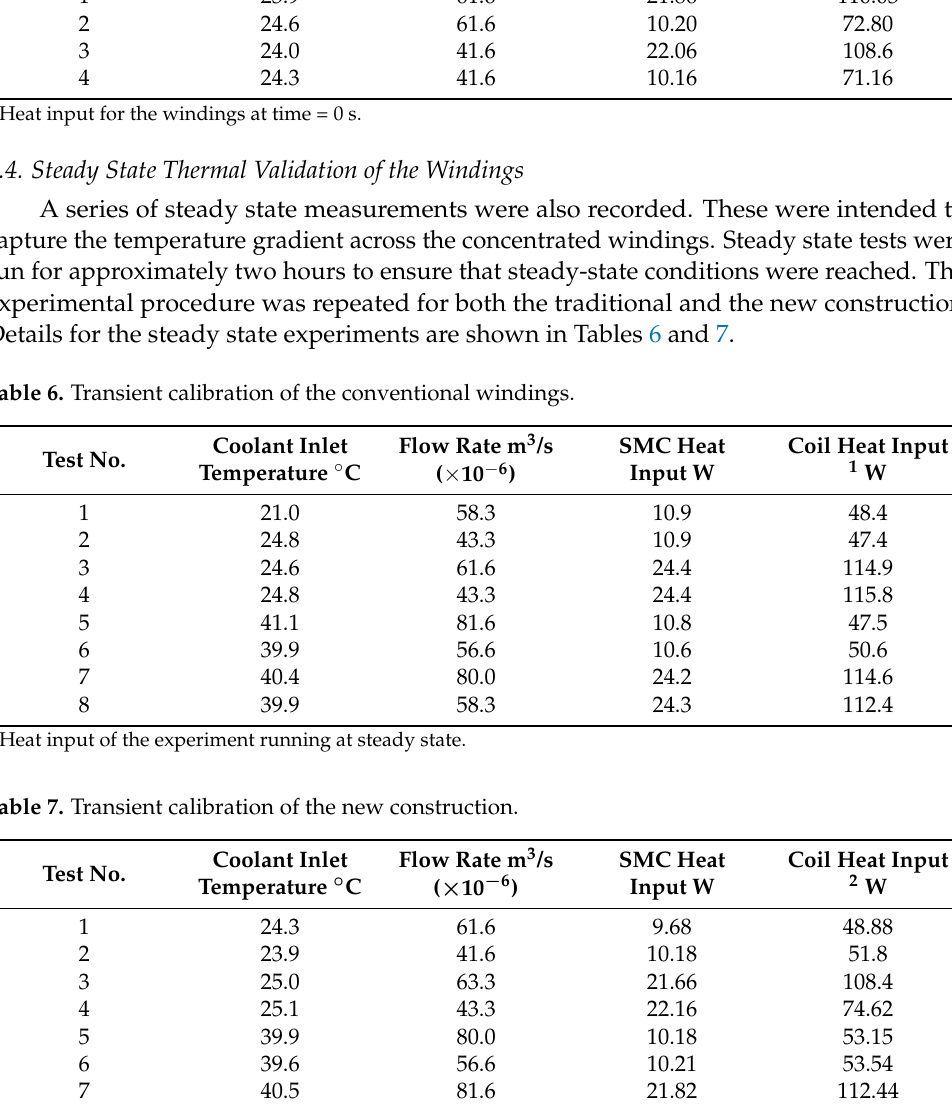
Table 5. Transient calibration of the new construction. Test No.